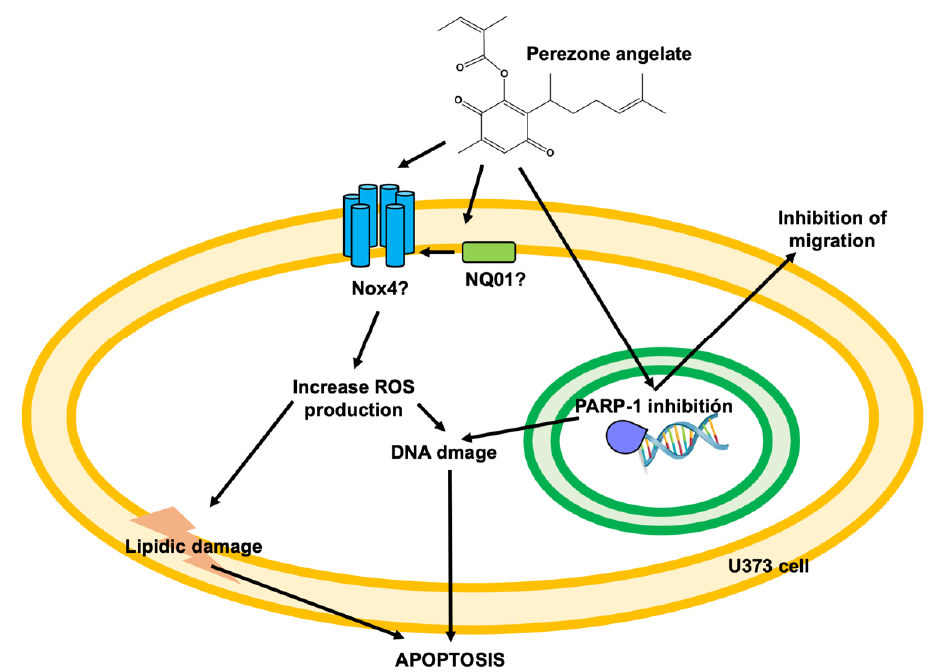
Figure 8. Proposed effects exerted by perezone angelate in U373 cells. Perezone angelate, similar to other quinones, can increase ROS production by Nox4 and NQO1. ROS production can produce both DNA and lipidic damage, resulting in apoptosis induction. In addition, PARP-1 inhibition avoids DNA reparation and contributes to DNA damage, thus contributing to apoptosis induction. Finally, PARP-1 inhibition can impair cell